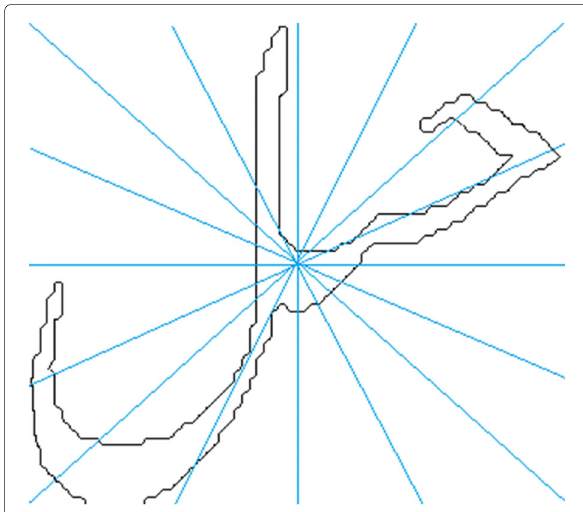
Fig. 5 Ligature image (after detection of Sobel edges) divided into 16 sectors around center